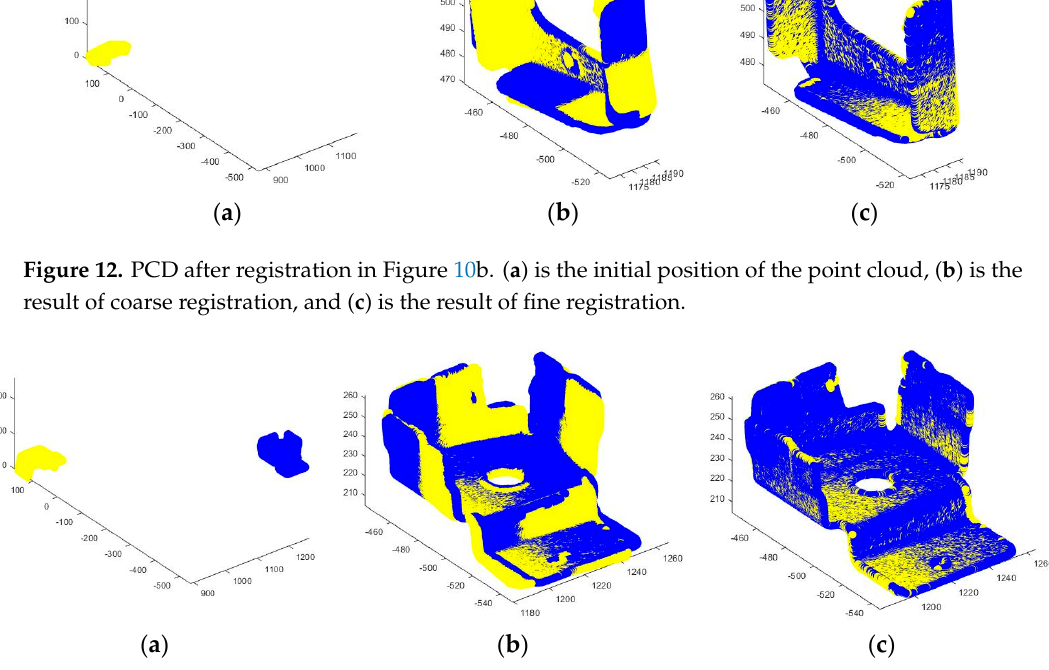
Figure 13. PCD after registration in Figure 10c. ( a ) is the initial position of the point cloud, ( b ) is the result of coarse registration, and ( c ) is the result of fine registration.